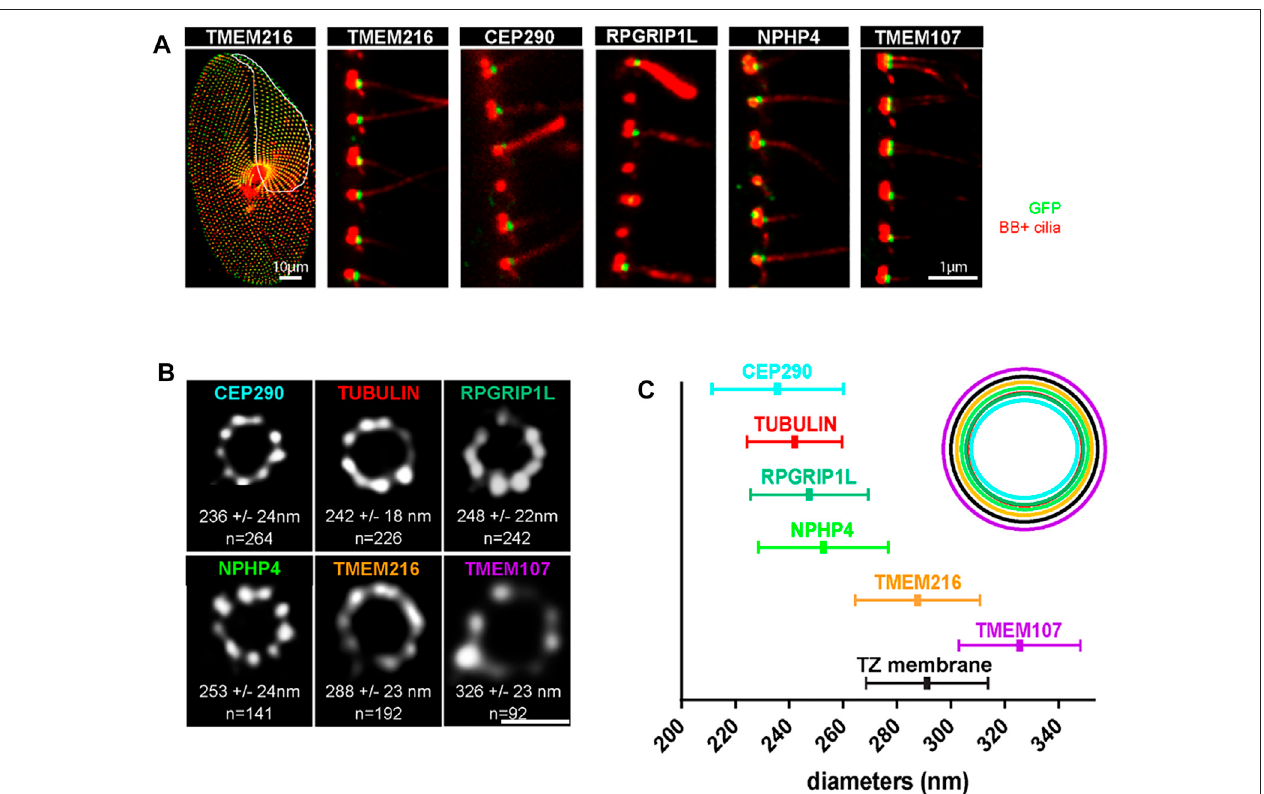
FIGURE8 |(A) Paramecia expressing different TZ proteins fused withGFP. Cells werepermeabilized before proceedingtoimmunostaining byID5 (decorating BB andciliainmagenta)andapolyclonalanti-GFP(ingreen).Leftpanel:surfaceviewofa Paramecium expressingTMEM216-GFP.Ciliatedbasalbodiesoftheinvariant fi eld (encircled in white) are stained by both GFP antibodies and ID5. In the other part of the cells, some basal bodies are labelled only by ID5. Right panels: confocal Z projections of ciliary rows, at the cell margin from TZ protein transformants. TMEM107-GFP, TMEM216-GFP, CEP290-GFP, and RPGRIP1L-GFP are localized only on the distal part of ciliated BBs. In addition, NPHP4-GFP can be observed at the BB proximal part. Note that ID5 antibodies better recognize short cilia. Bars = 10 and1 μ m. (B) RepresentativeSTEDimagesrevealingdistinctlocalizationpatternsofseveralGFP-taggedTZproteins.Cellswerelabelledwithanti-GFPorID5(tubulin).A singleringdifferingindiameterisobservedaccordingtotheobservedprotein.Themeandiameters(distancebetweenintensitymaxima)andthenumberofBBsanalyzed aregivenbeneath eachimage,2replicates. (C) Graph (left)showingthe meandiameter±StandardDeviationofeach toroidlabeledbyeach GFPtagged TZprotein (see (B) . Top right, schema representing the relative position of all toroids with respect to the position of tubulin and the ciliary membrane. Each TZ protein is shown in a different color reproduced from Gogendeau et al, 2020, PLoS Biol 18(3): e3000640. 10.1371/journal.pbio.3000640.